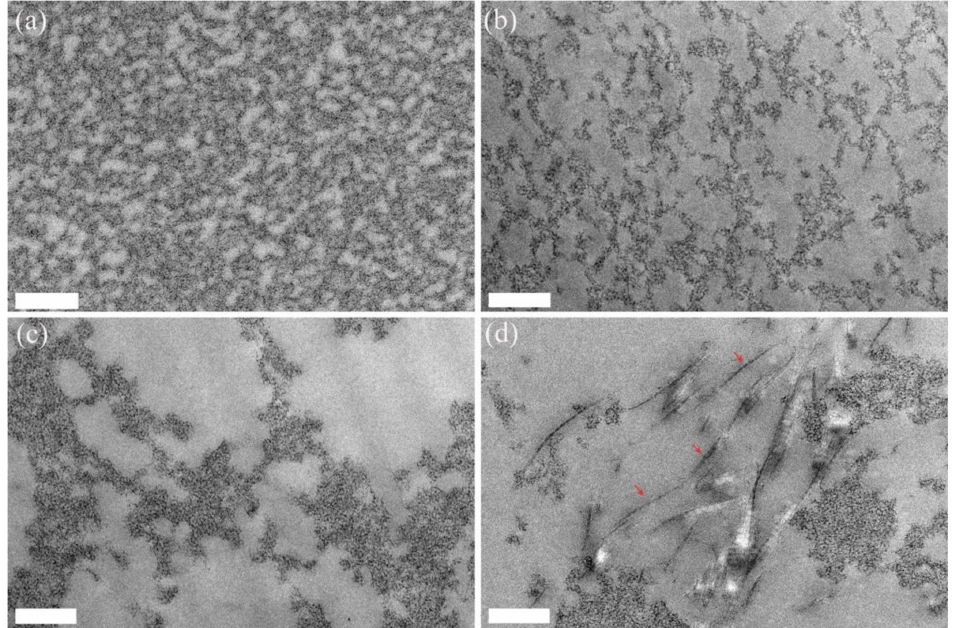
Figure 4. TEM images of the fibrin and fibrin-collagen hydrogels: ( a ) pure fibrin at 20 mg.mL − 1 ; ( b ) fibrin 20 mg.mL − 1 :collagen 2.5 mg.mL − 1 ; ( c ) fibrin 20 mg.mL − 1 :collagen 5 mg.mL − 1 ; ( d ) fibrinogen 20 mg.mL − 1 :collagen 10 mg.mL − 1 . (Scale bar = 500 nm). Red arrows indicate collagen